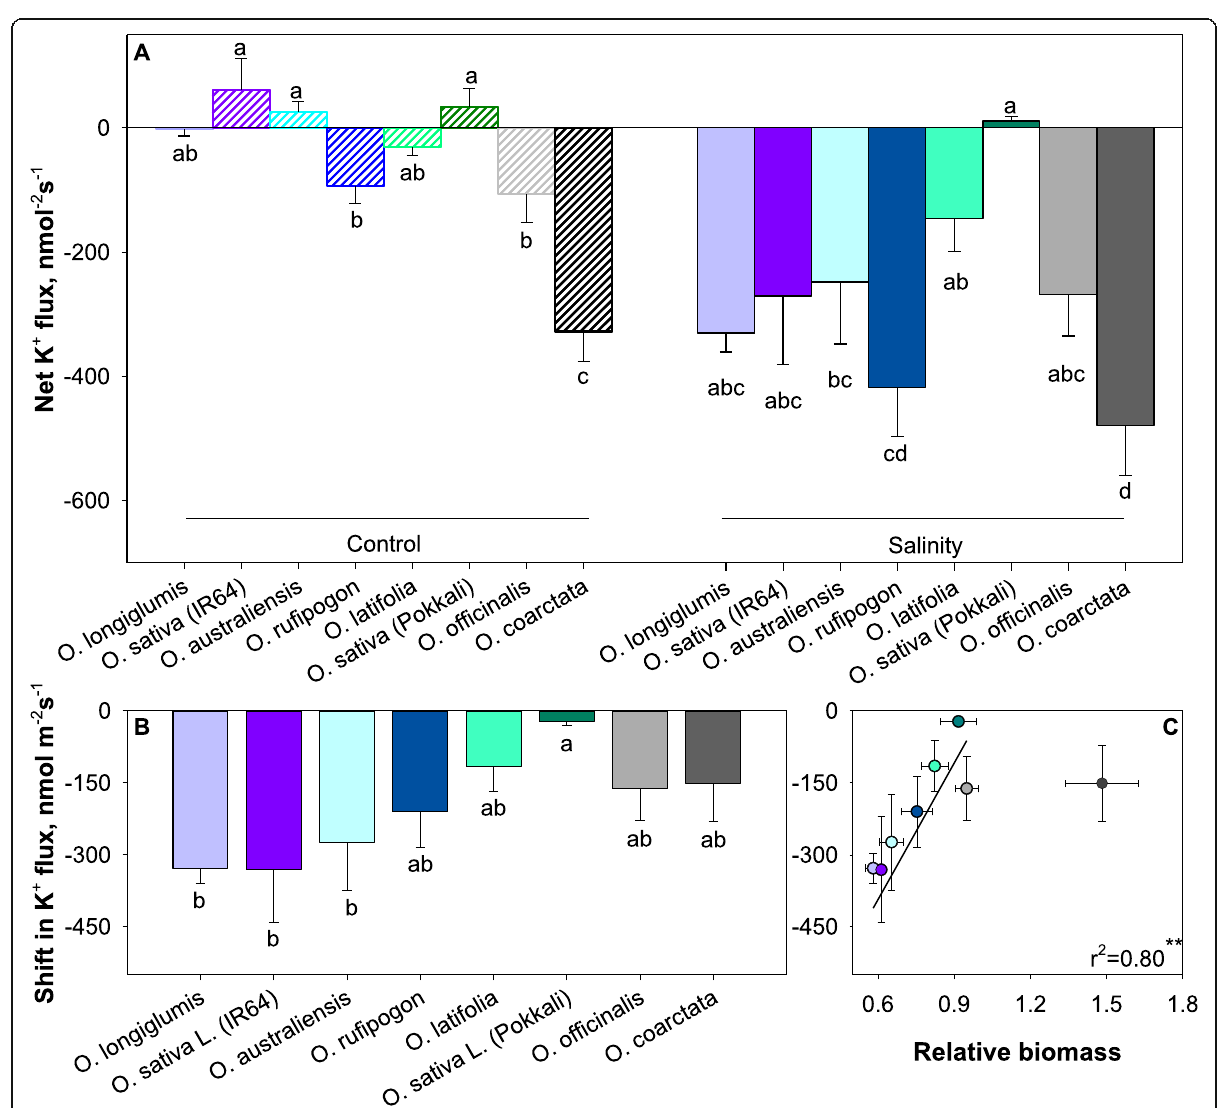
Fig. 2 Linking salinity tolerance of wild and cultivated rice to net K + ion fluxes of mesophyll cells ( A ) after 42days of 100mM NaCl treatment. The shift in K + flux was the flux difference between flux from salinity-stressed and control samples ( B ). Pearson analysis of shift in K + flux with relative biomass ( C ). Data are mean values and the error bars indicate the standard errors. Different lowercase letters indicate significant differences at P<0.05 for each Duncan